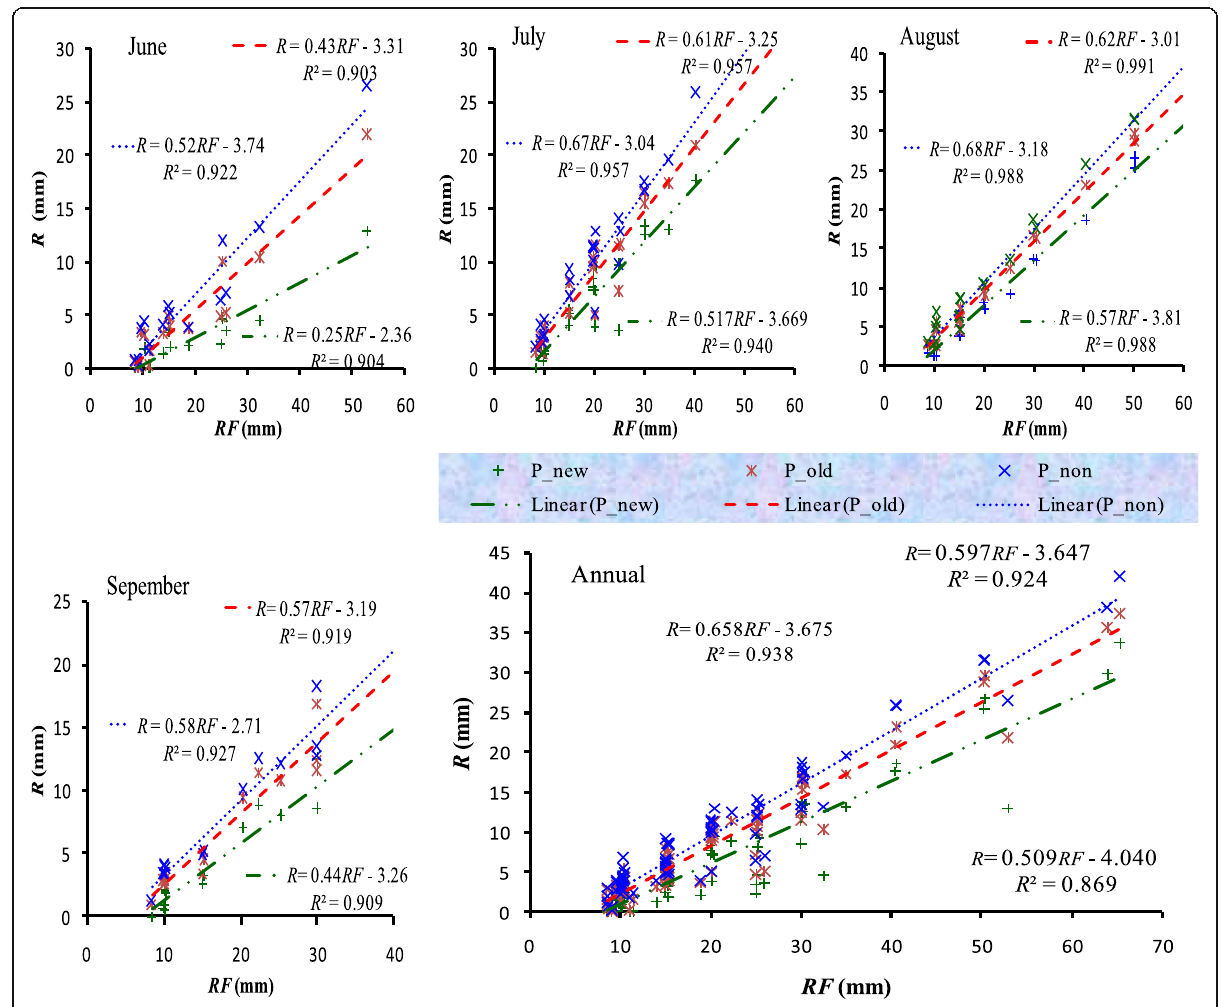
Fig. 6 Monthly and annual rainfall-runoff relationship under different conservation